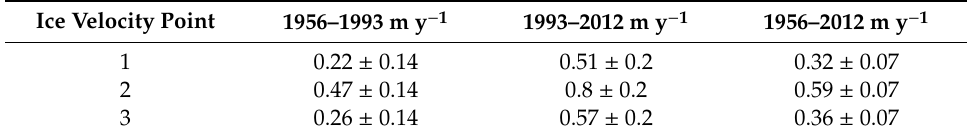
Table 3. Surface velocities between 1956 and 2012 (Figure